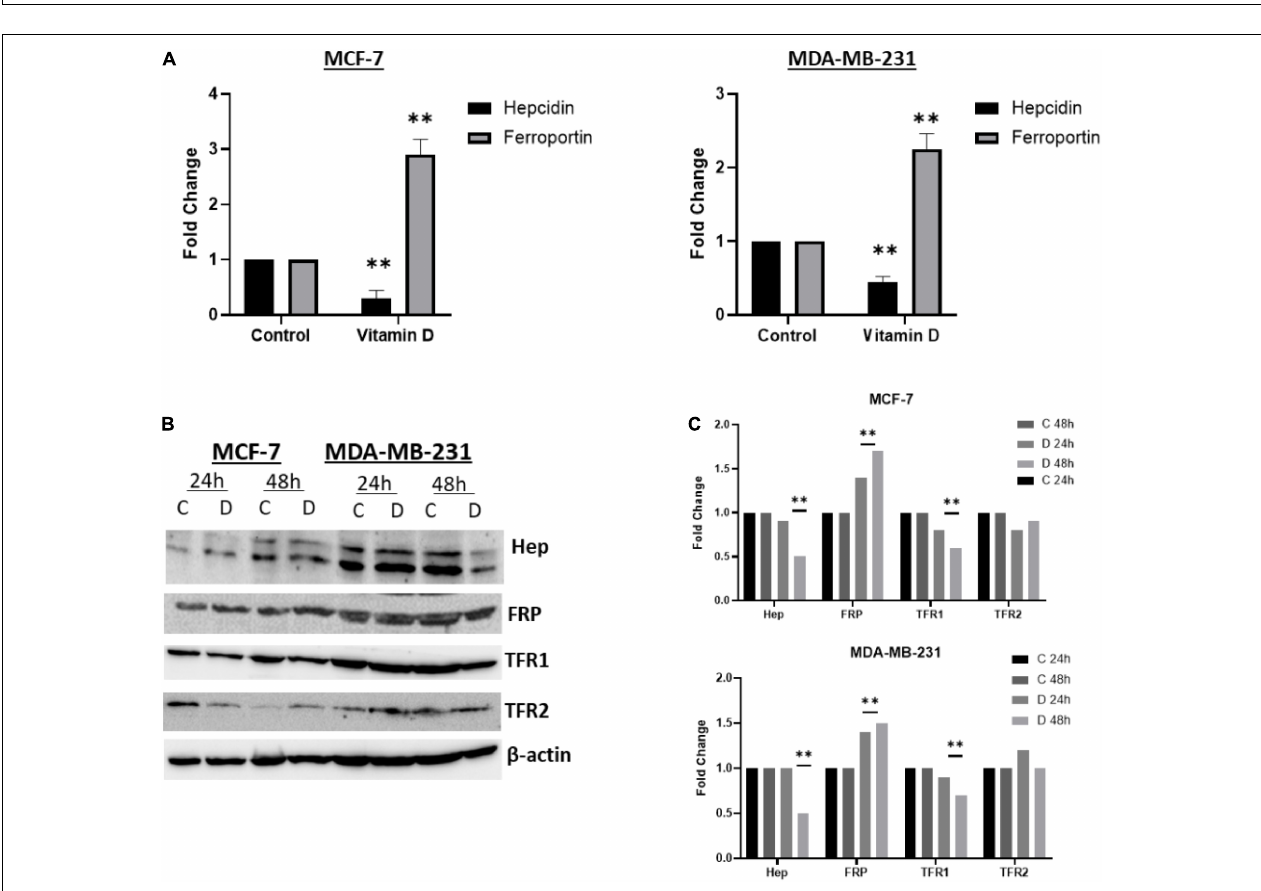
FIGURE 2 | Assessment of BRCA cell viability following vitamin D treatment. Percentage cell viability of (A) MCF-7 and (B) MDA-MB-231 cells treated with 0.001, 0.01, 0.1, 1, and 10 µ M vitamin D for 24, 48, and 72 h as measured by the MTT assay. **Represents statistically significant change ( P < 0.01) in cell survival between calcitriol-treated and untreated controls at each time point tested.